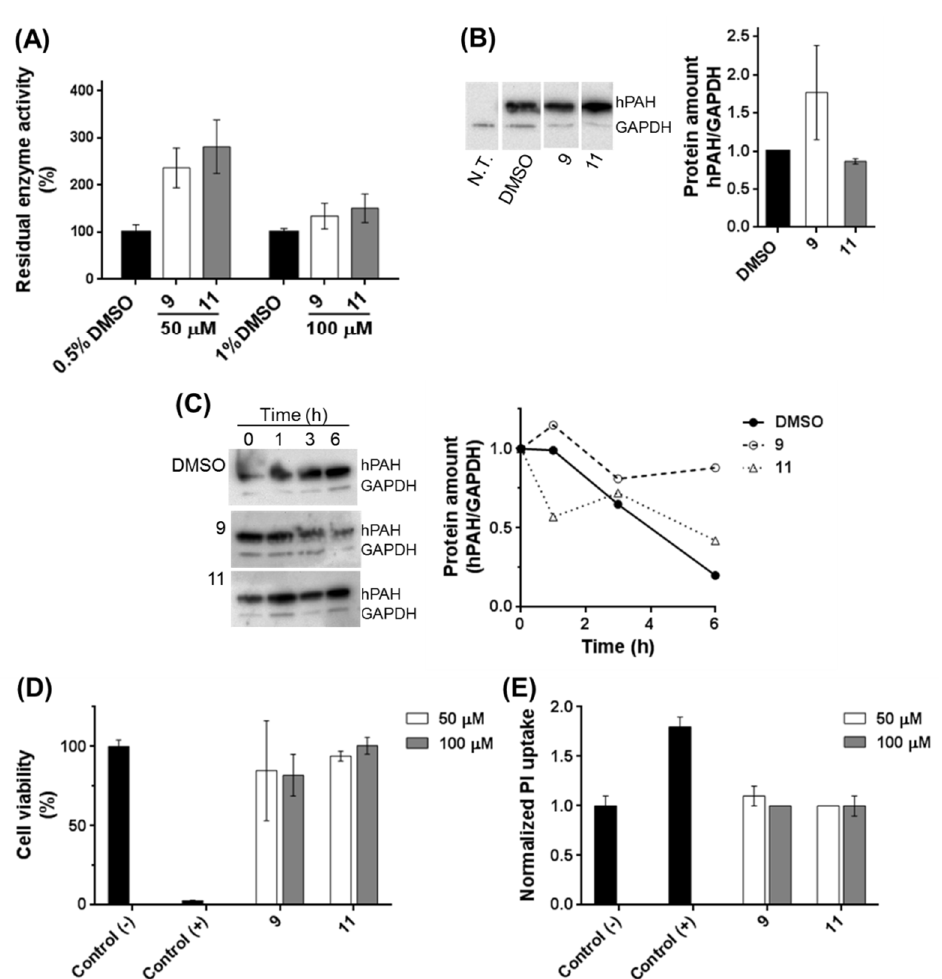
Figure 8. Compounds 9 and 11 increased the level and activity of human phenylalanine hydroxylase (hPAH) transiently expressed in HEK-293T cells and were shown to be biocompatible. ( A ) Effect of compounds 9 and 11 (50 and 100 µ M) on hPAH activity after 24 h incubation and using DMSO (0.5 and 1%) as the control; enzyme activity was calculated as the amount of tyrosine (nmol) produced per min, per mg total protein in cell lysate and represent the mean ± SD from three independent assays each performed in triplicate. ( B ) Amount of hPAH after 24 h incubation and using 50 µ M of compounds; protein amount was normalized using GAPDH as an internal control; (N.T.) Cells not transfected with expression vector. ( C ) Cells were incubated with 50 µ M of compounds 9 or 11 for 24 h and protein synthesis was arrested using 10 µ g/mL puromycin; cellular lysates were analyzed for protein amounts 1, 3, and 6 h after translation blockage; assays were performed in duplicate. ( D , E ). Cytotoxicity of 3HQ derivatives; compounds were tested at 50 and 100 µ M, in HEK-293T cells, for cell viability ( D ) and propidium iodide (PI) uptake ( E ), using 1% DMSO as the negative control and sodium dodecyl sulphate (SDS) as the positive cytotoxic control; cell viability was determined by the percentage of Alamar Blue reduction ( D ); the value obtained for the negative control was considered 100%; retention rate of PI was determined relatively to the negative control which was considered 1. Data represent the mean ± SD from three independent assays each performed in triplicate. Uncropped western blot images are shown in Supplementary Figure S7.